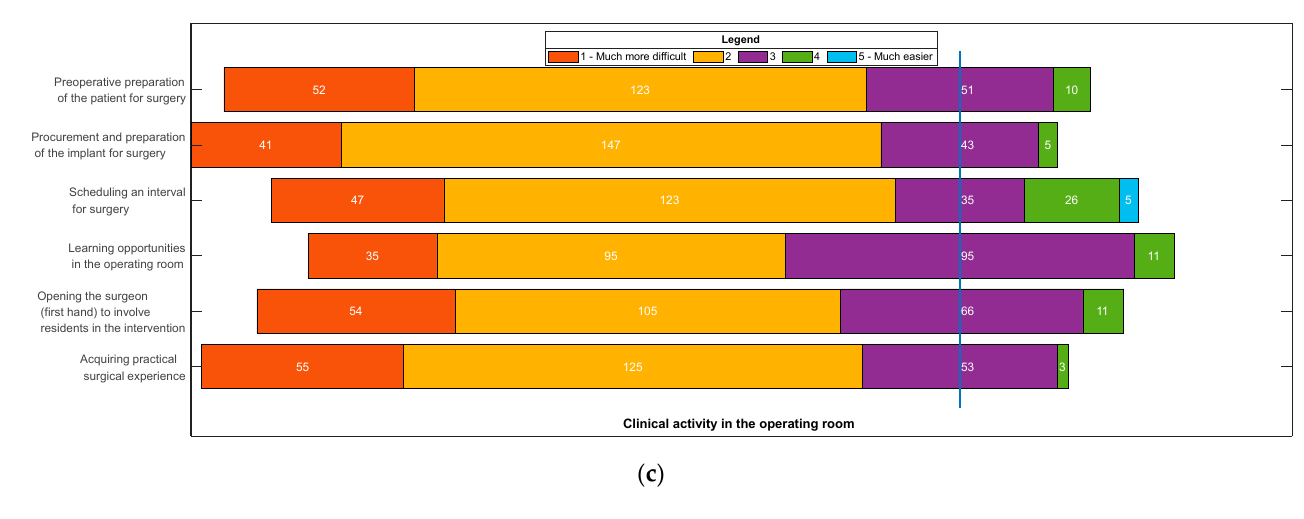
Figure 1. Likert scale of the degree of difficulty regarding the development of clinical activity: ( a ) Clinical activity on duty/emergency room/outpatient ward; ( b ) Clinical activity of hospitaliza- tion/discharge; ( c ) Clinical activity in the operating room. Steps on the Likert scale: ( 1 ) Much more difficult in pandemic than in ante-pandemic; ( 2 ) More difficult in pandemic compared to ante-pandemic; ( 3 ) In the pandemic, as well as in ante-pandemic; ( 4 ) Easier in pandemic than in ante-pandemic; ( 5 ) Much easier in the pandemic compared to the ante-pandemic period.